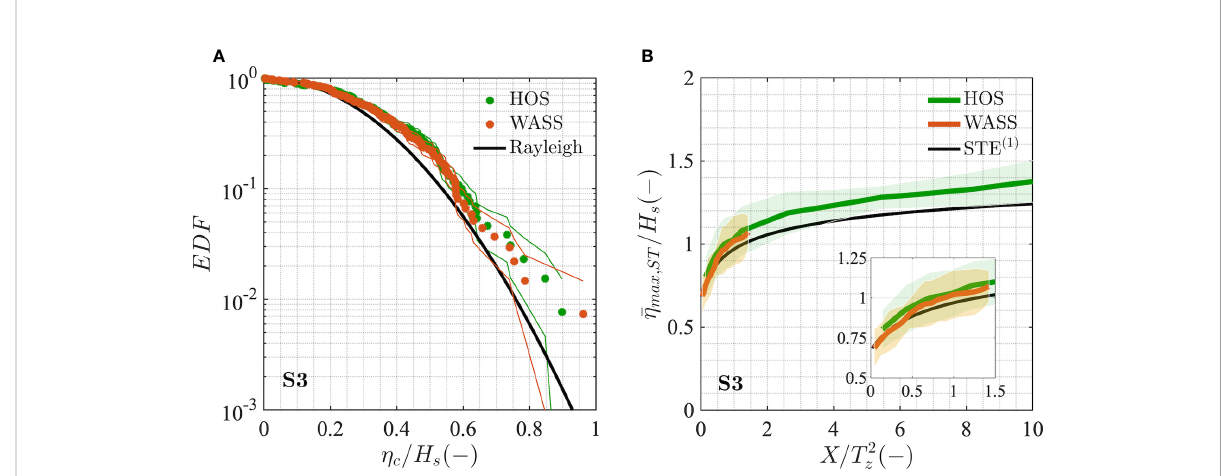
FIGURE 4 Exceedance distribution function of dimensionless crest heights ( h c /H s ) at a fi xed point (A) and space-time extreme distributions of expected normalized maximum wave crest heights ( (cid:1) h max,ST /H s ) as a function of the normalized sea surface area width X = T 2 z (B) from HOS (green circles) and one 20-minute WASS record (orange circles). The stability bands (coloured lines) and the standard deviation (shaded area) are also shown. The inset plot in panel (B) shows an enlargement of the distributions for the overlapping range of sea surface area widths. Reference statistical distributions at a fi xed point and for space-time extremes are shown with a black line (Rayleigh and STE (1)